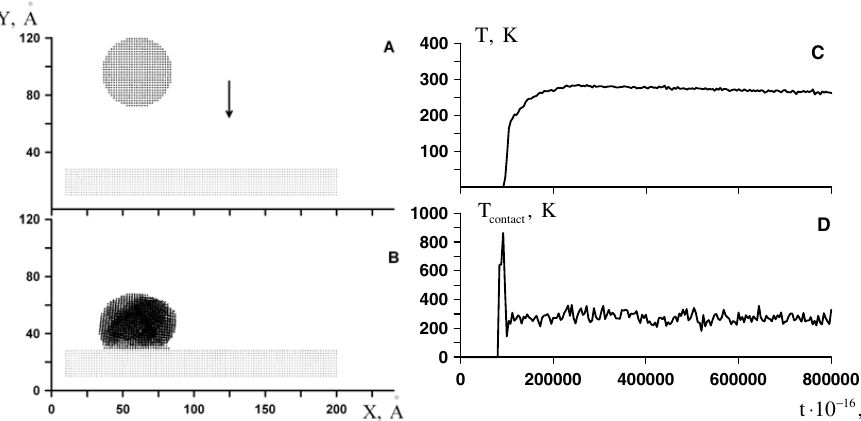
Fig. 1. Initial (A) and final (B) positions of the cluster and substrate in the XY plane. Dependences of cluster kinetic temperature (C) and kinetic temperature in the contact region (D) versus time. Cluster diameter is 50Å. Initial velocity is 500m /